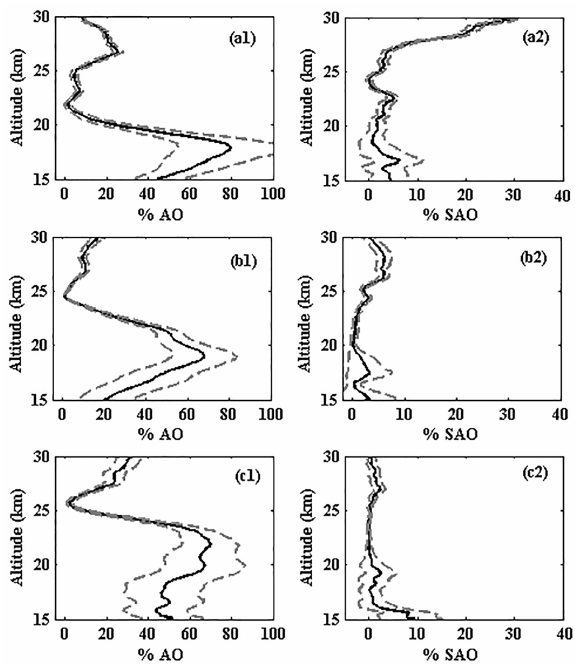
Figure 10. Height profile in % of the contribution of the annual cy- cle (a1–c1) and the semi-annual cycle (a2–c2) to ozone variability as calculated by the Trend-Run model over the equatorial (a1, a2) , tropical (b1, b2) and subtropical (c1, c2) regions. SDs associated with contributions are presented in grey dotted